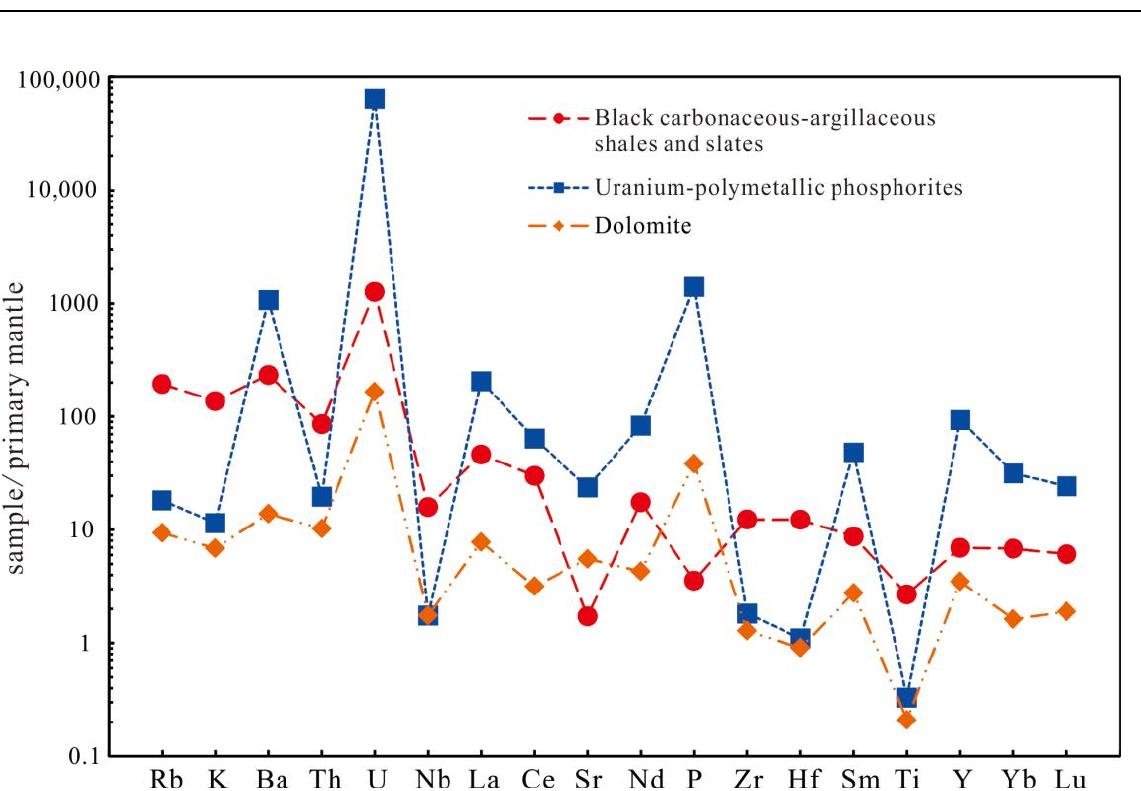
Figure 3. The standardized cobweb map of the trace elements in the primitive mantle.